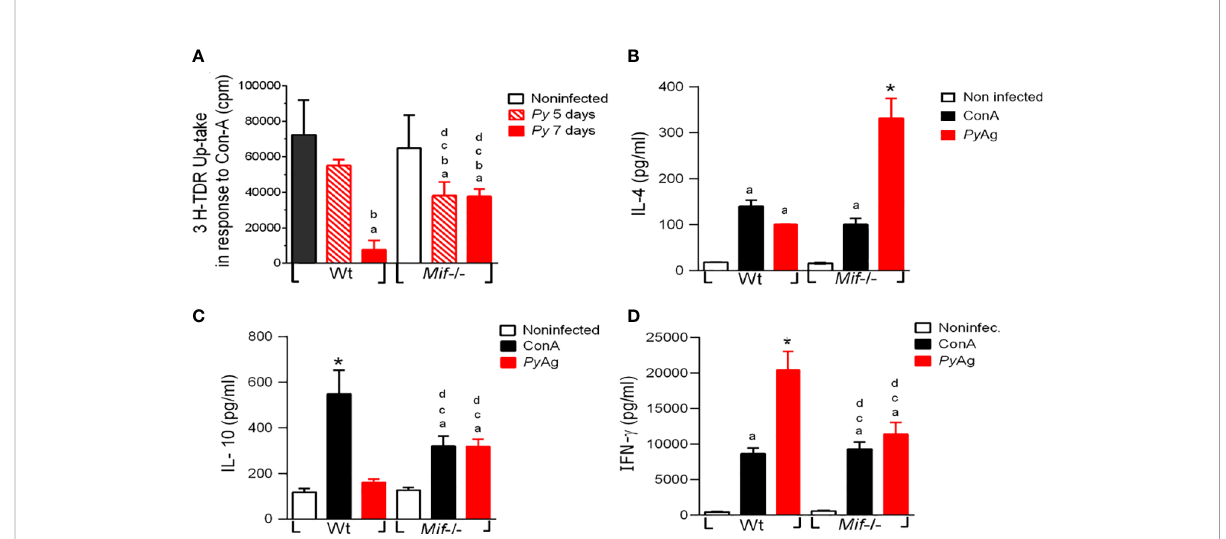
FIGURE 6 Plasmodium yoelii 17XL infection promotes high IL-4 and IL-10 and low IFN- g production by Mif -/- spleen cells after Py Ag stimulation. Spleen cells from Wt and Mif -/- mice were isolated at day 7 postinfection. (A) Proliferation was assessed in freshly isolated spleen cells upon stimulation with ConA for 5 days. Cytokines (B) IL-4, (C) IL-10, and (D) IFN- g were measured in supernatants. The bars represent the mean ± SEM incorporation of 3H-TDR from 2 independent experiments. In (B-D) , data are expressed as the mean ± SEM and are representative of 3 independent experiments with at least 3 to 5 mice per group. Values of p < 0.05 were considered statistically signi fi cant, (a) compared with the noninfected WT group, (b) compared with the ConA+ Py -infected Wt group, (c) compared with the Py Ag + Py -infected Wt group, (d) compared with the noninfected Mif -/- group (*) compared with all experimental groups, and (&) compared with the Py -infected 5 days post infection Wt